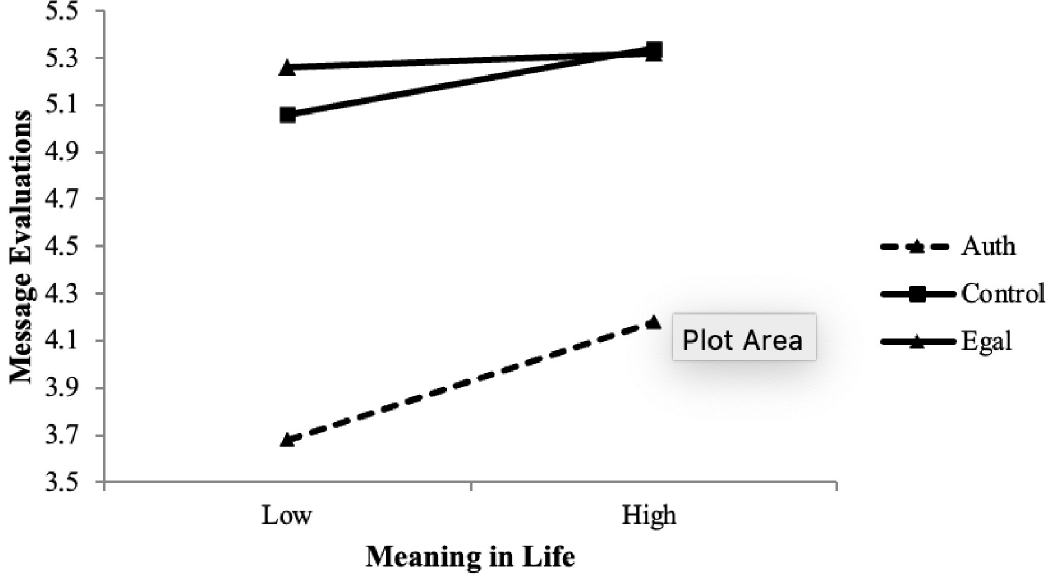
Fig 3. Interaction of post-manipulation meaning in life X authoritarian dummy predicting message evaluations, pooled data, Studies 3–5. Note . The slope for the authoritarian condition is significantly stronger in the authoritarian condition than the egalitarian condition but does not differ from the control